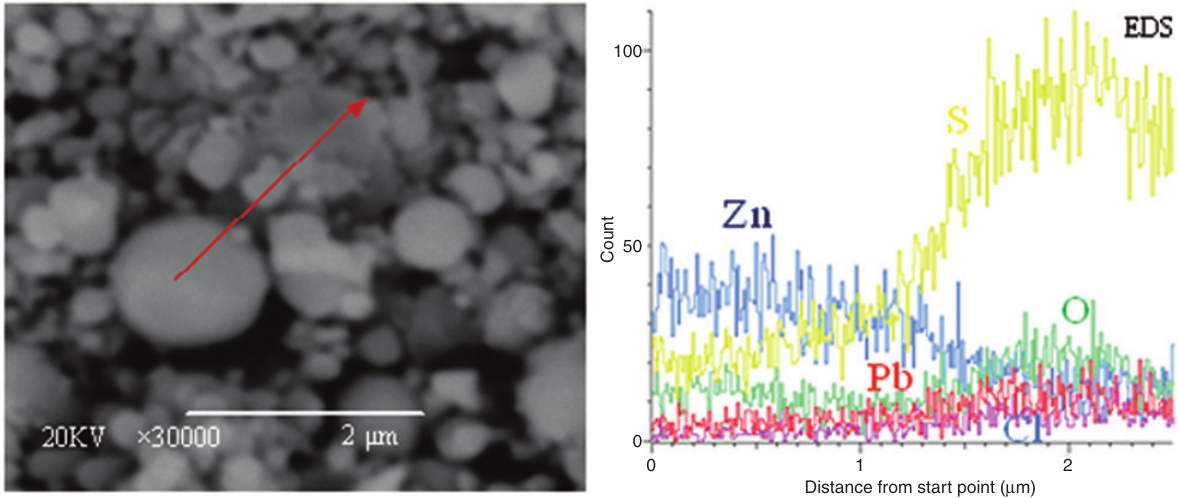
Figure 3: Energy dispersive spectroscopy (EDS) line scanning results of zinc oxide dust sample (red line).